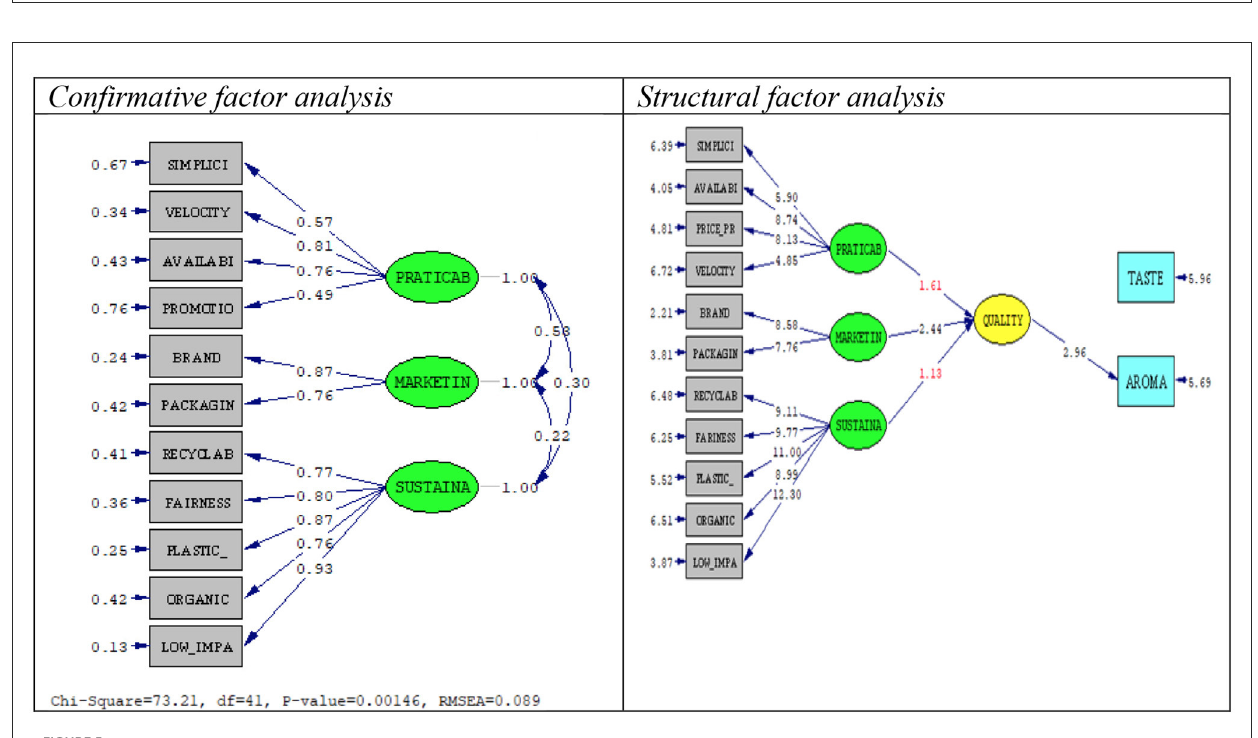
FIGURE5 Confirmative and structural analysis for middle-age